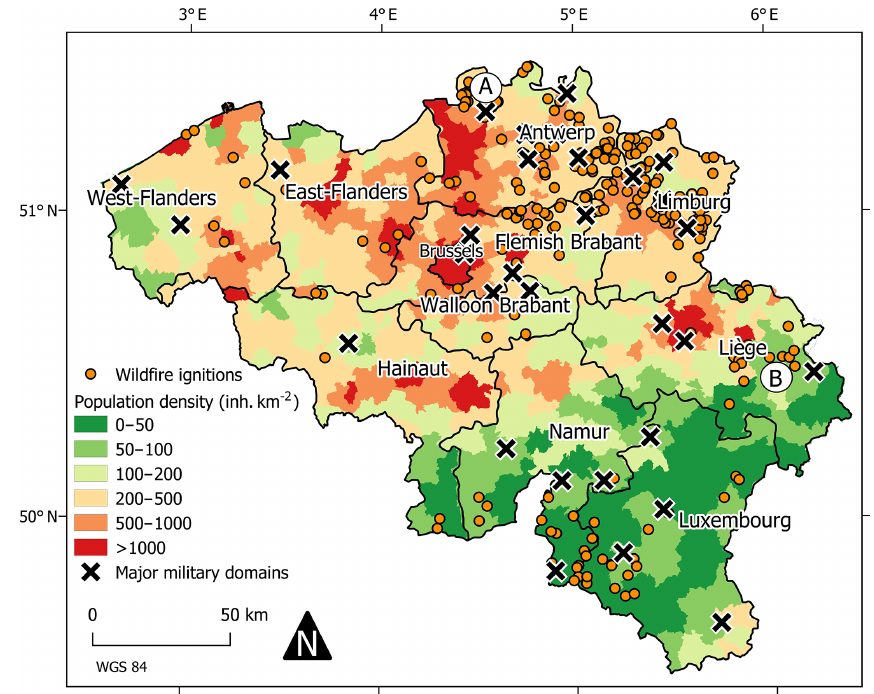
Figure 1. Belgium, its 10 provinces, and the Brussels Capital Region. The map displays the wildfire ignitions in Belgium between 1994 and 2016 and the major military domains (Sect. 3.1). The population densities were provided by the NGI (http://www.ngi.be/NL/NL1-5-2.shtm, last access: 11 October 2017). A: “de Kalmthoutse Heide”; B: “les Hautes